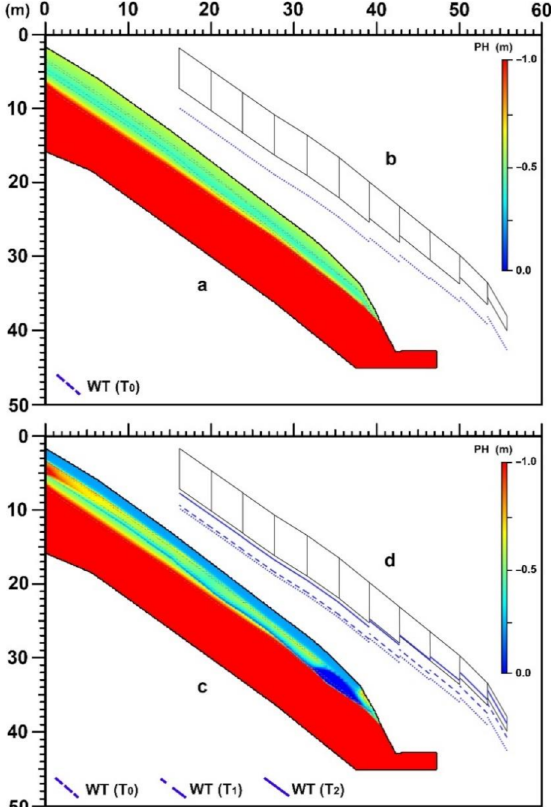
Figure 4. Results of hydrological modeling with Variably Saturated Two Dimensional (VS2D ver- sion 1.3) for a representative slope [77] showing the antecedent conditions ( a ) and variation soil-water pressure head (PH) distribution with formation of near saturated/saturated zones closely upslope of morphological discontinuities ( c ). Corresponding results of TRIGRS simulation showing the rise in the hypothetical water table through time ( b , d ). Both modeling results show the influence of reduction in ash-fall pyroclastic soil cover thickness on hydrologic response to